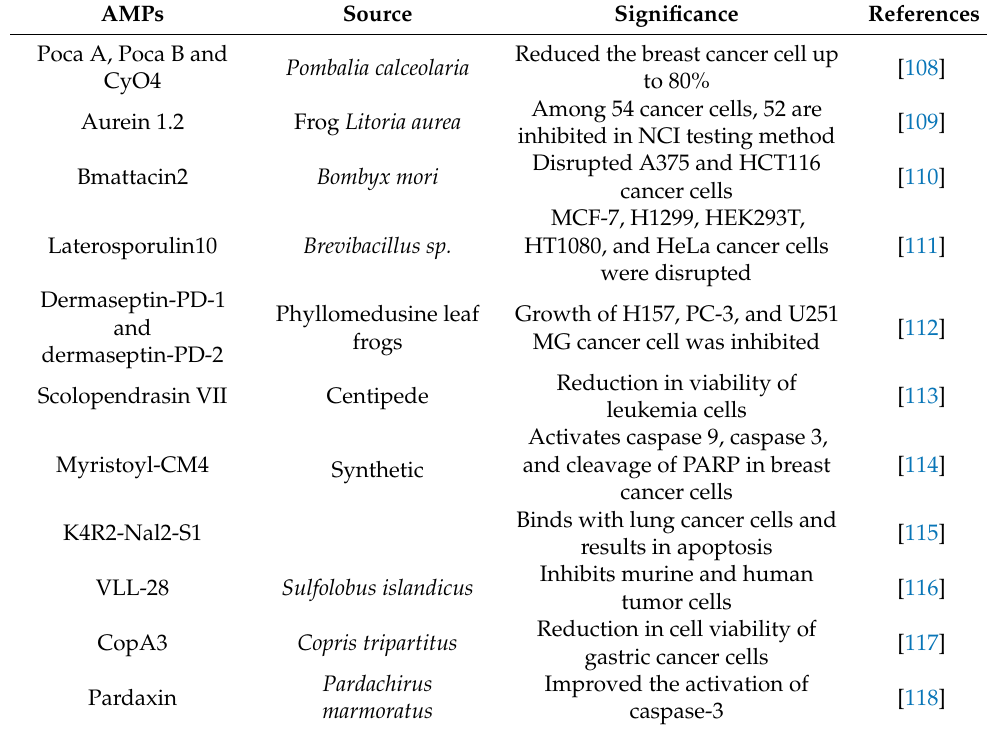
Table 5. List of some of the AMPs that can be used in cancer therapeutic